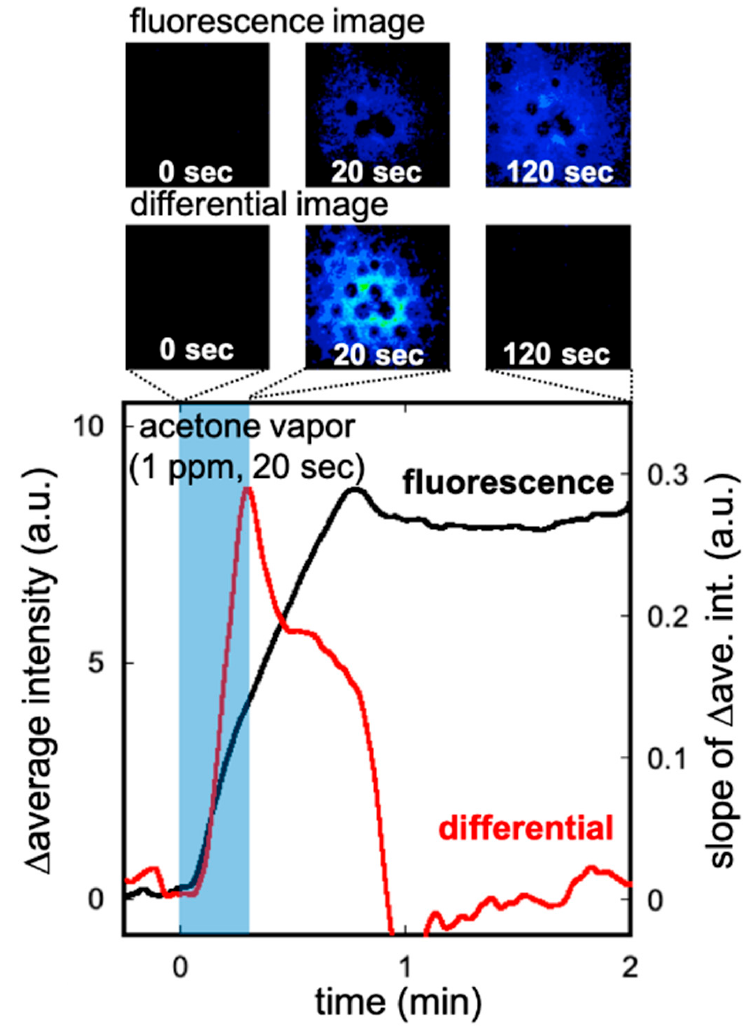
Figure 5. Change in fluorescence intensity over time in the imaging of acetone vapor (1.0 ppm), and results of the differential analysis after creating a running average based on the data. Inset images: fluorescence images (above) and differential analysis images (below).